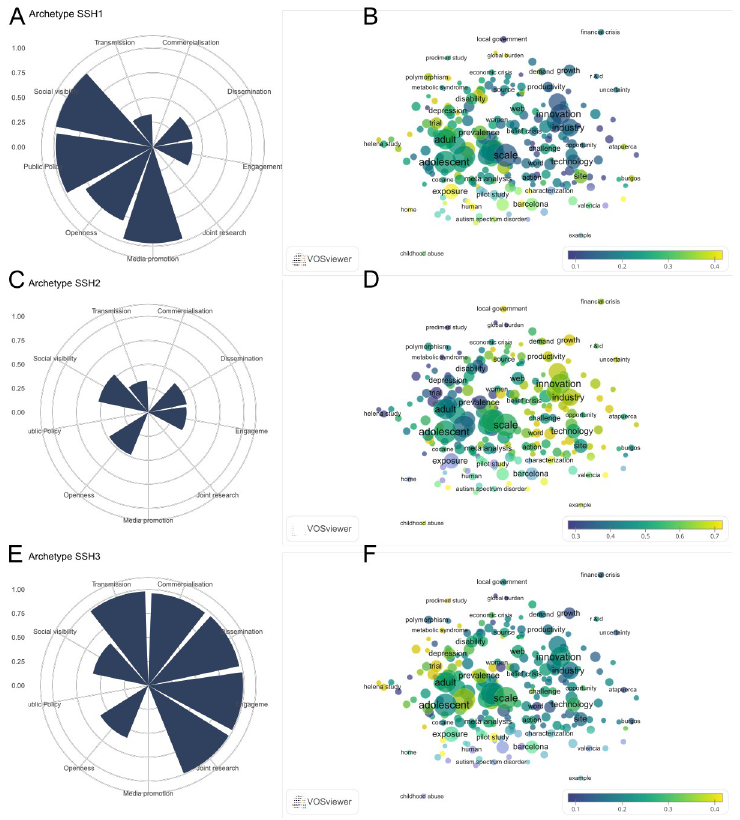
Fig 5. Parameters and topic maps for two archetypes in SSH field. Archetypes that emerge for all SSH cases (A and C), along with overlay maps of α scores corresponding to words included in the titles of research publications (B and D). Words follow a colour grading based on their maximum or minimum value, the extreme values being yellow (for those present in publication titles of cases resembling a given archetype) and blue (those which are not present in the publication titles of cases resembling the archetype). An online version of this map is available at: http://sl.ugr.es/